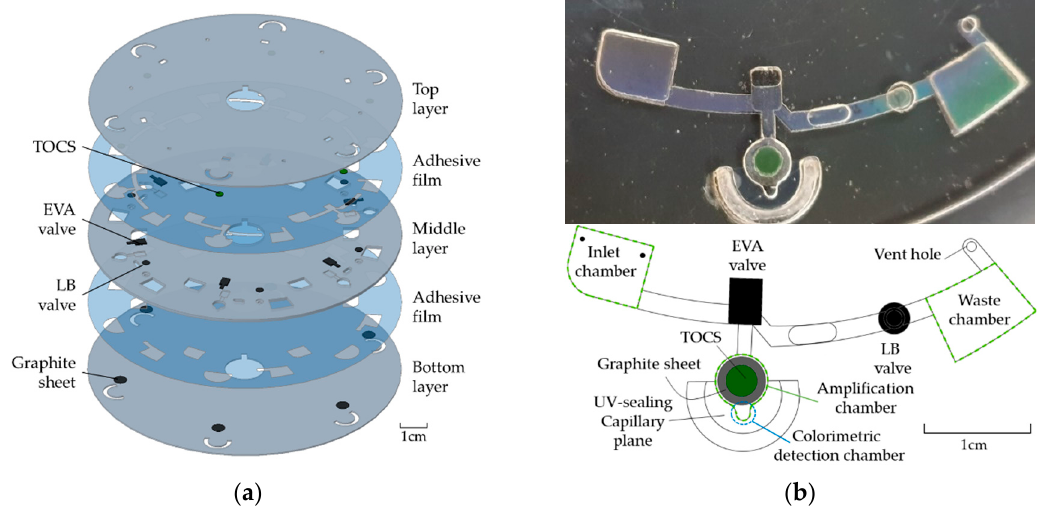
Figure 1. Disc figure; ( a ) disassembled disc, ( b ) top view.